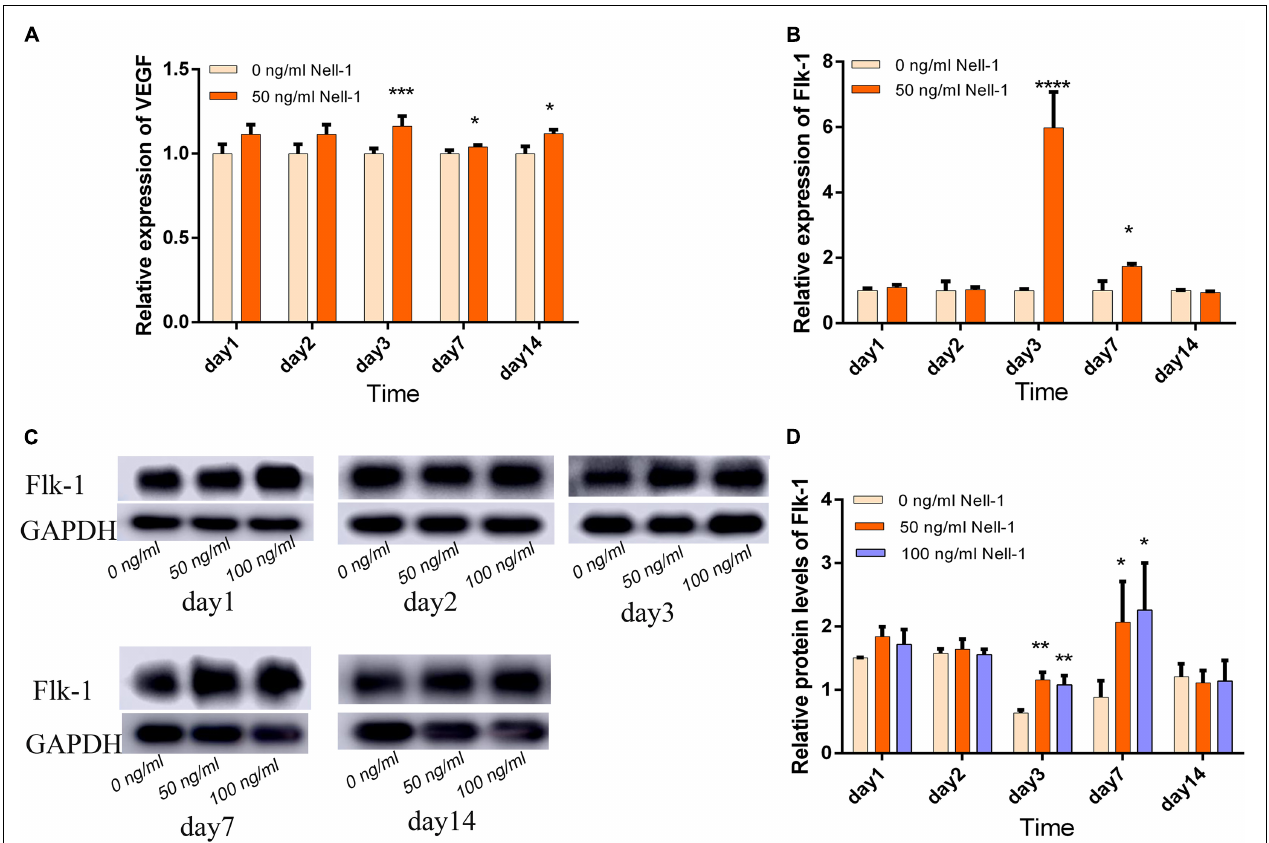
FIGURE 2 | Angiogenesis-related gene and protein expression in DPSCs. (A) VEGF gene expression was increased by 50 ng/mL Nell-1 treatment in days 3, 7, and 14. (B) Flk-1 gene expression was increased by 50 ng/mL Nell-1 treatment in days 3 and 7. (C,D) Flk-1 protein expression was increased by 50 and 100 ng/mL Nell-1 treatment in days 3 and 7. Data are shown as the mean ± SD. (* p < 0.05, ** p < 0.01, *** p < 0.001, **** p < 0.0001).